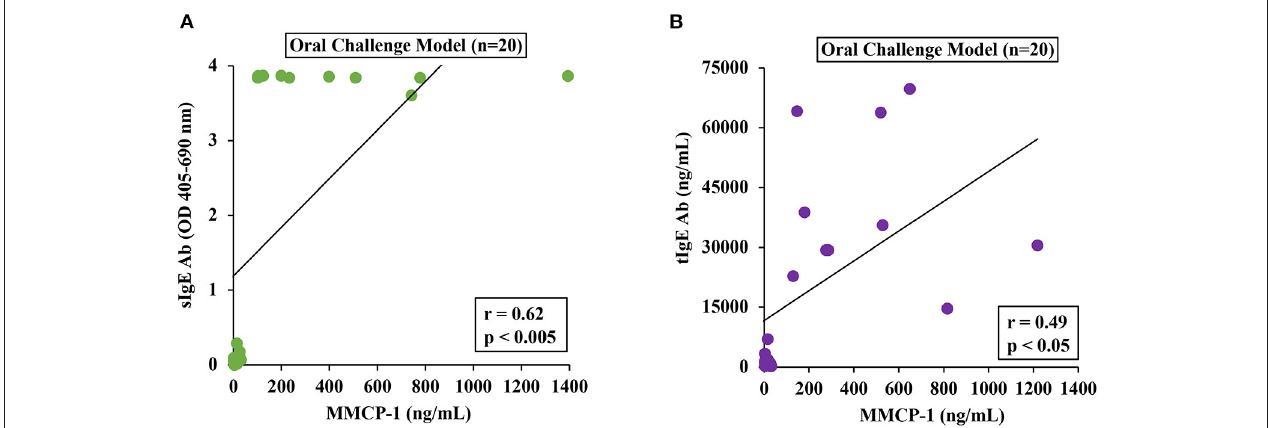
FIGURE 6 | Mucosal mast cell responses upon challenge with durum SSPE correlated with specific and total IgE levels. Mice were treated as described in MATERIALS AND METHODS. Pearson correlation analysis was used to test the relationship between MMCP-1 levels (ng/ml) and antibody responses (sIgE or tIgE) in the plasma after 8th transdermal exposure (8R) to SSPE. Data from saline challenged control mice ( n = 10) and SSPE-challenged (20mg) allergic mice ( n = 10) via the oral route. (A) Pearson correlation analysis between sIgE and MMCP-1 levels in orally challenged (OC) mice. (B) Pearson correlation analysis between tIgE and MMCP-1 levels in orally challenged (OC) mice. sIgE, specific IgE; tIgE, total IgE; Ab,